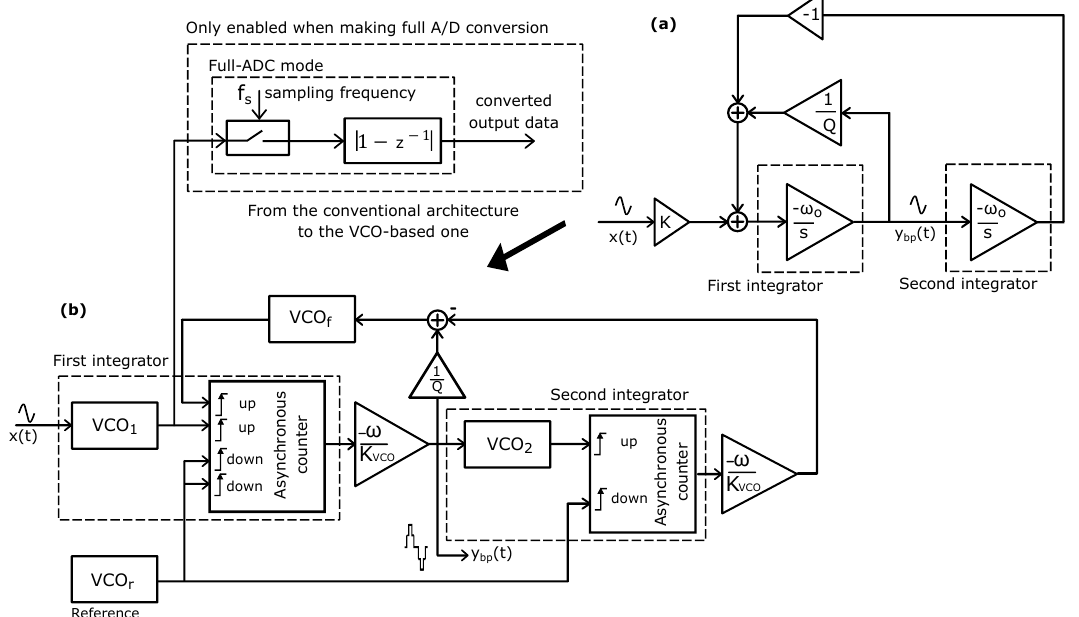
Figure 3. Conventional ( a ) and proposed ( b ) single-ended voltage-controlled-oscillators (VCO)-based architectures for a bi-quadratic